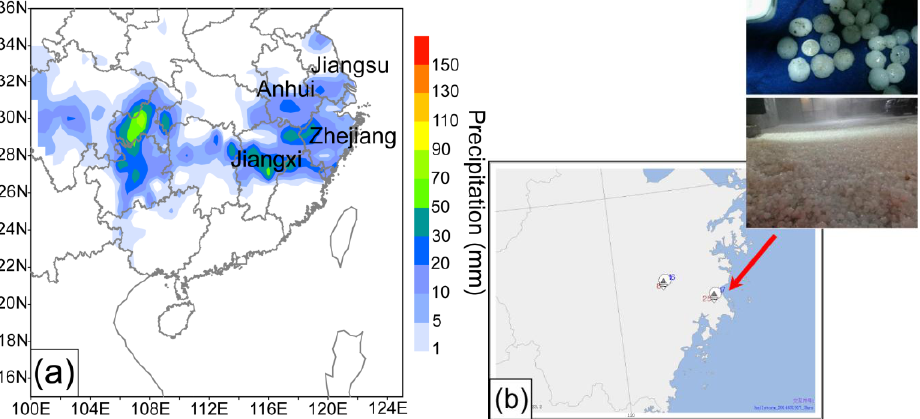
Figure 8. ( a ) The 24-hr accumulated rainfall on 19 March 2014. ( b ) Hailstorms observed at Taizhou city in Zhejiang province of China.